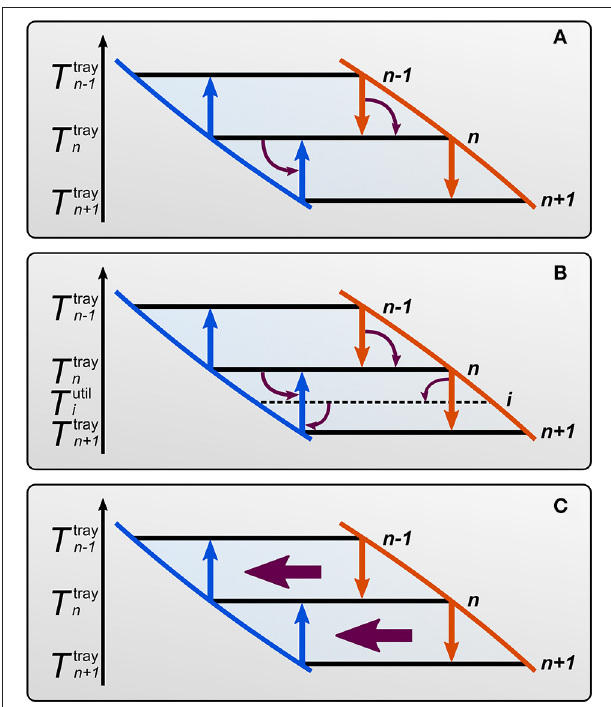
FIGURE 3 | Schematic illustration of the heat integration model: For classic distillation columns by consideration of one utility for each tray (A) , and for the exploitation of additional degrees of freedom: Applying indirect heat integration (B) , and direct heat integration (C) .